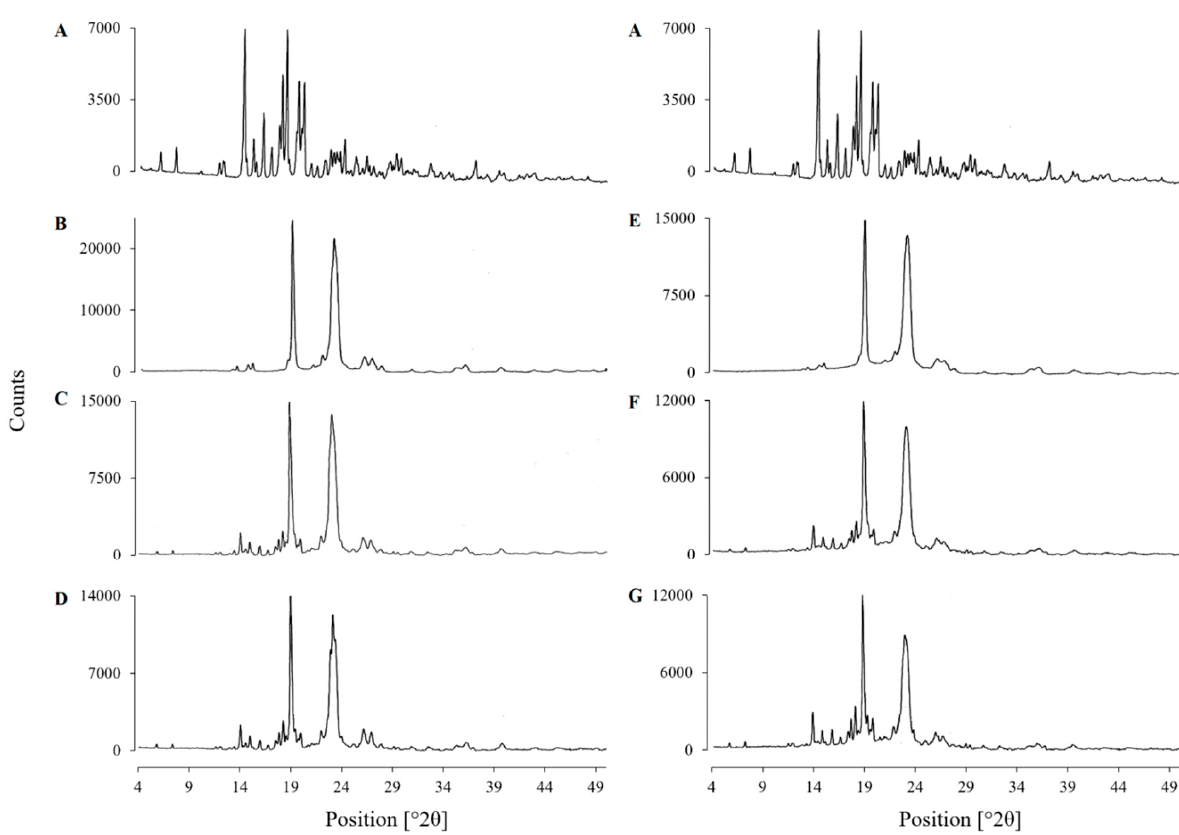
Figure 4. X-ray powder diffractograms (XRPD) of ( A ) Supplied FFH, ( B ) Supplied PEG 20,000, ( C ) Physical mixture of FFH with PEG 20,000 at 1:4 ratio (PM-FP20K (1:4) ), ( D ) Solid dispersion of FFH with PEG 20,000 at 1:4 ratio (SD-FP20K (1:4) ), ( E ) Supplied poloxamer 188, ( F ) Physical mixture of FFH with poloxamer 188 at 1:4 ratio (PM-FP188 (1:4) ), ( G ) Solid dispersion of FFH with poloxamer 188 at 1:4 ratio (SD-FP188 (1:4) ).